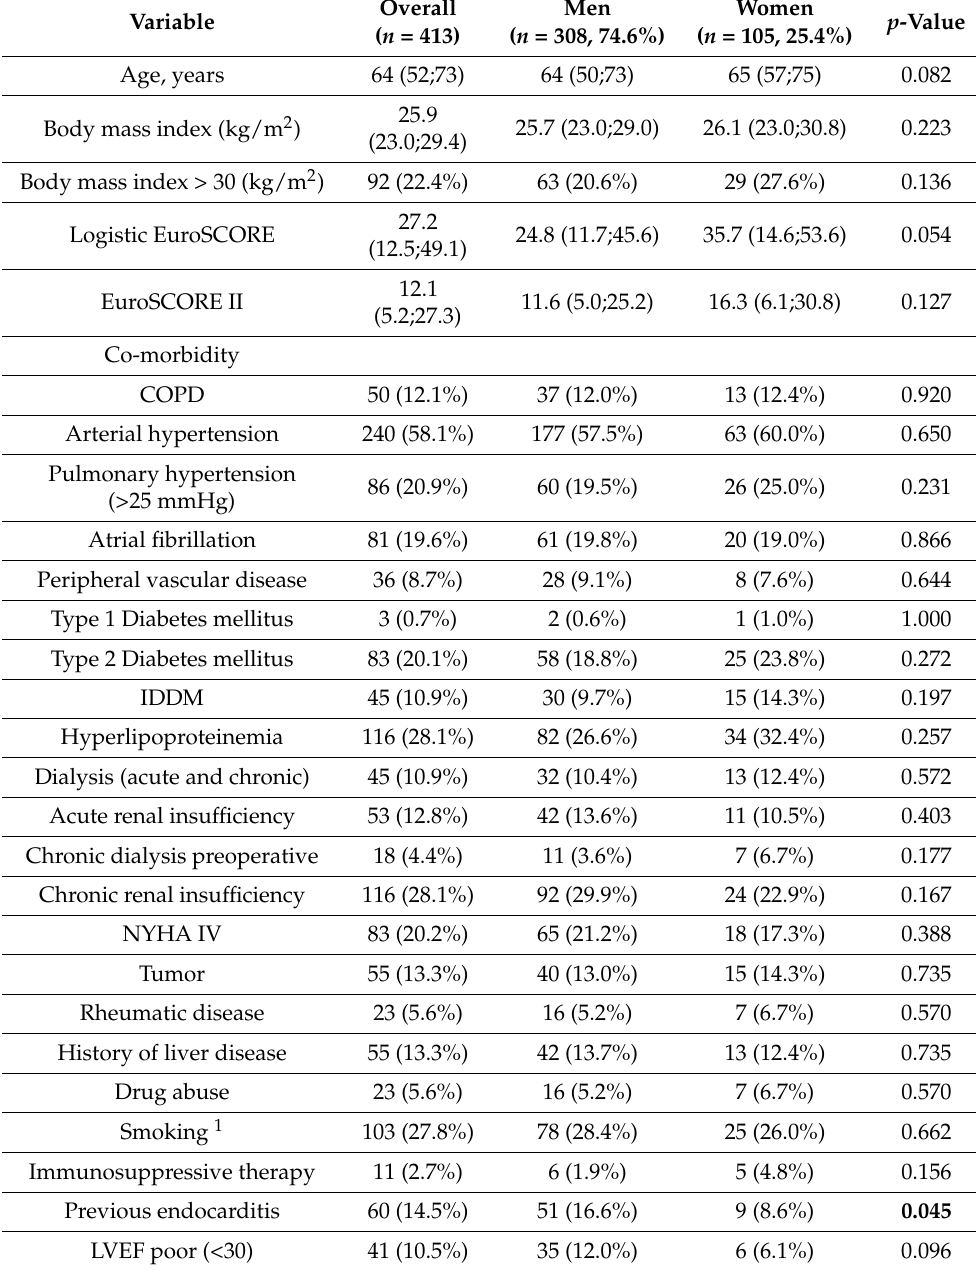
Table 1. Baseline patient characteristics stratified by